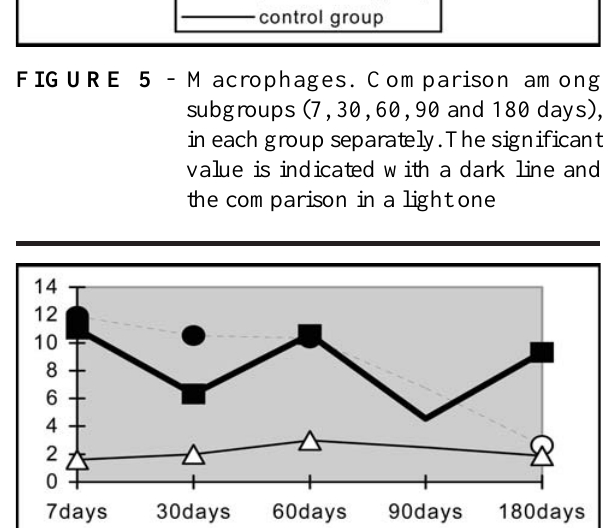
FIGURE 6 - Macrophages. Comparison among the silicone, bonded e-ptfe and control groups, separately in each subgroup (7, 30, 60, 90 and 180 days). The significant value is indicated with a dark line and its